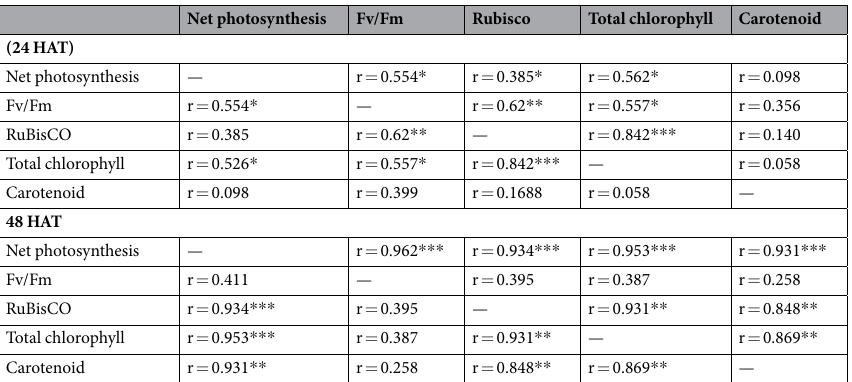
Table 1. Linear correlations among the descriptive parameters of Net-photosynthesis, and photosynthetic parametres. The values measured at 24 and 48 HAT after CO, NO x , CH 4 and C 3 H 8 treatment were used for correlation analysis. The correlation coefficient (r) and significant differences are given; n = 16. * P ≤ 0.05; ** P ≤ 0.01; *** P ≤